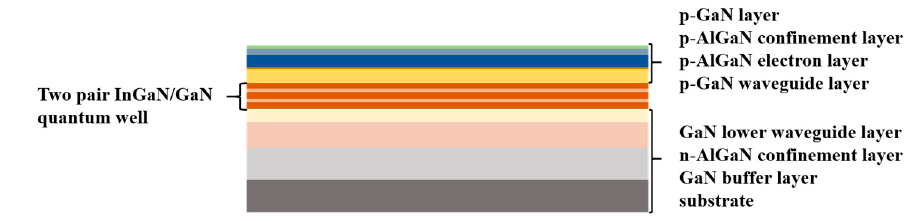
Figure 1. Schematic of GaN based laser diode structure.